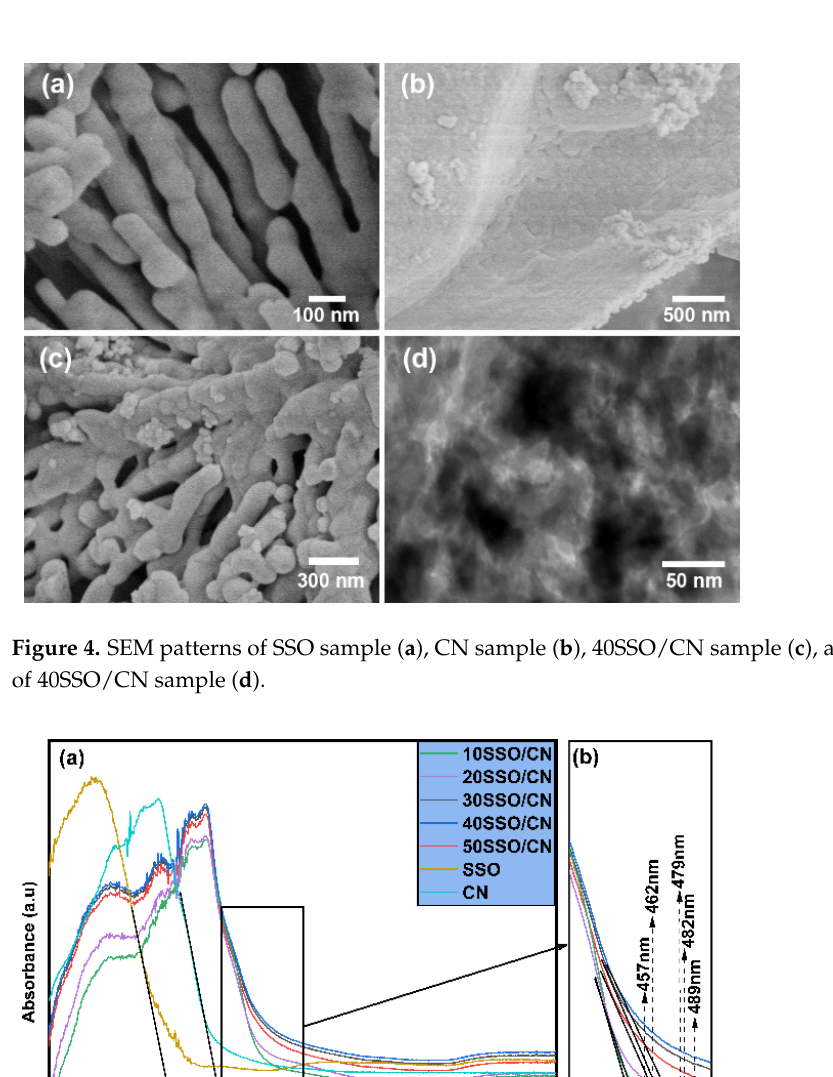
Figure 3. XPS survey pattern of 40SSO/CN ( a ); the high-resolution XPS spectra of Sr 3d ( b ), Sn 3d